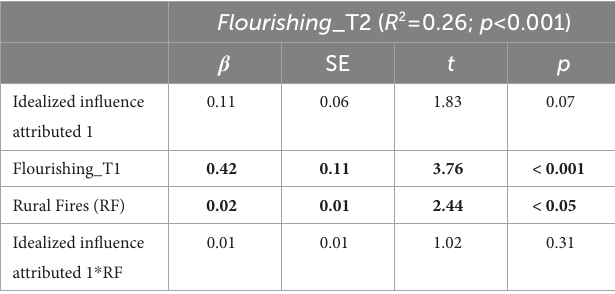
TABLE 2 Analysis of the effect and moderation between the variables under study—Idealized influence attributed